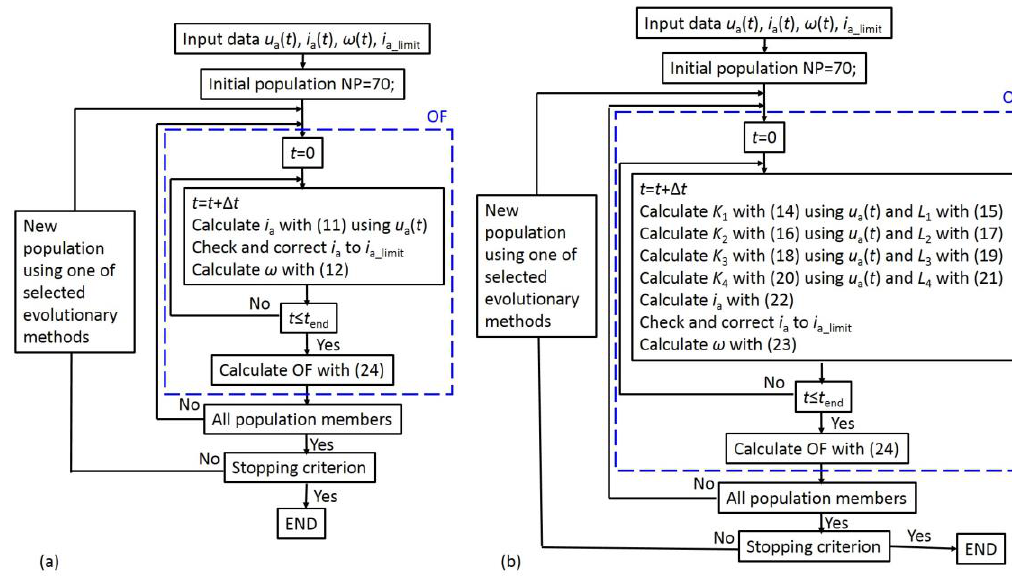
Figure 4. Algorithms for parameter determination using: ( a ) EM; ( b ) RK.